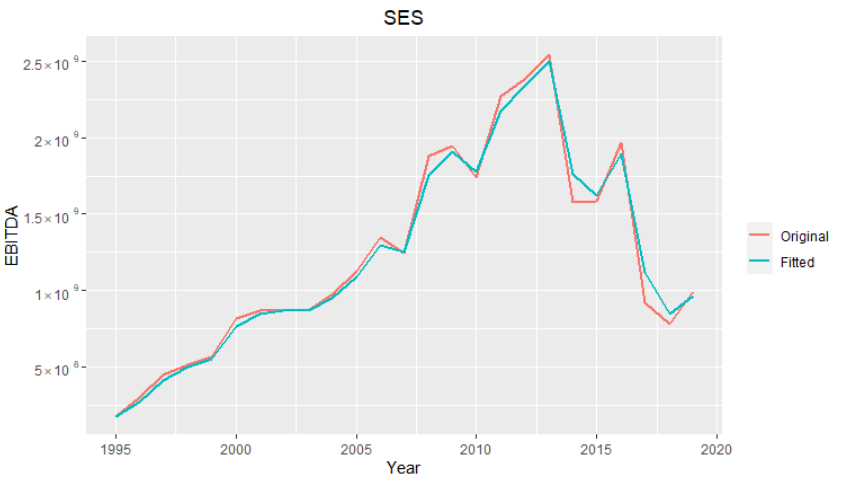
Figure 5. SES model for the EBITDA index with λ =